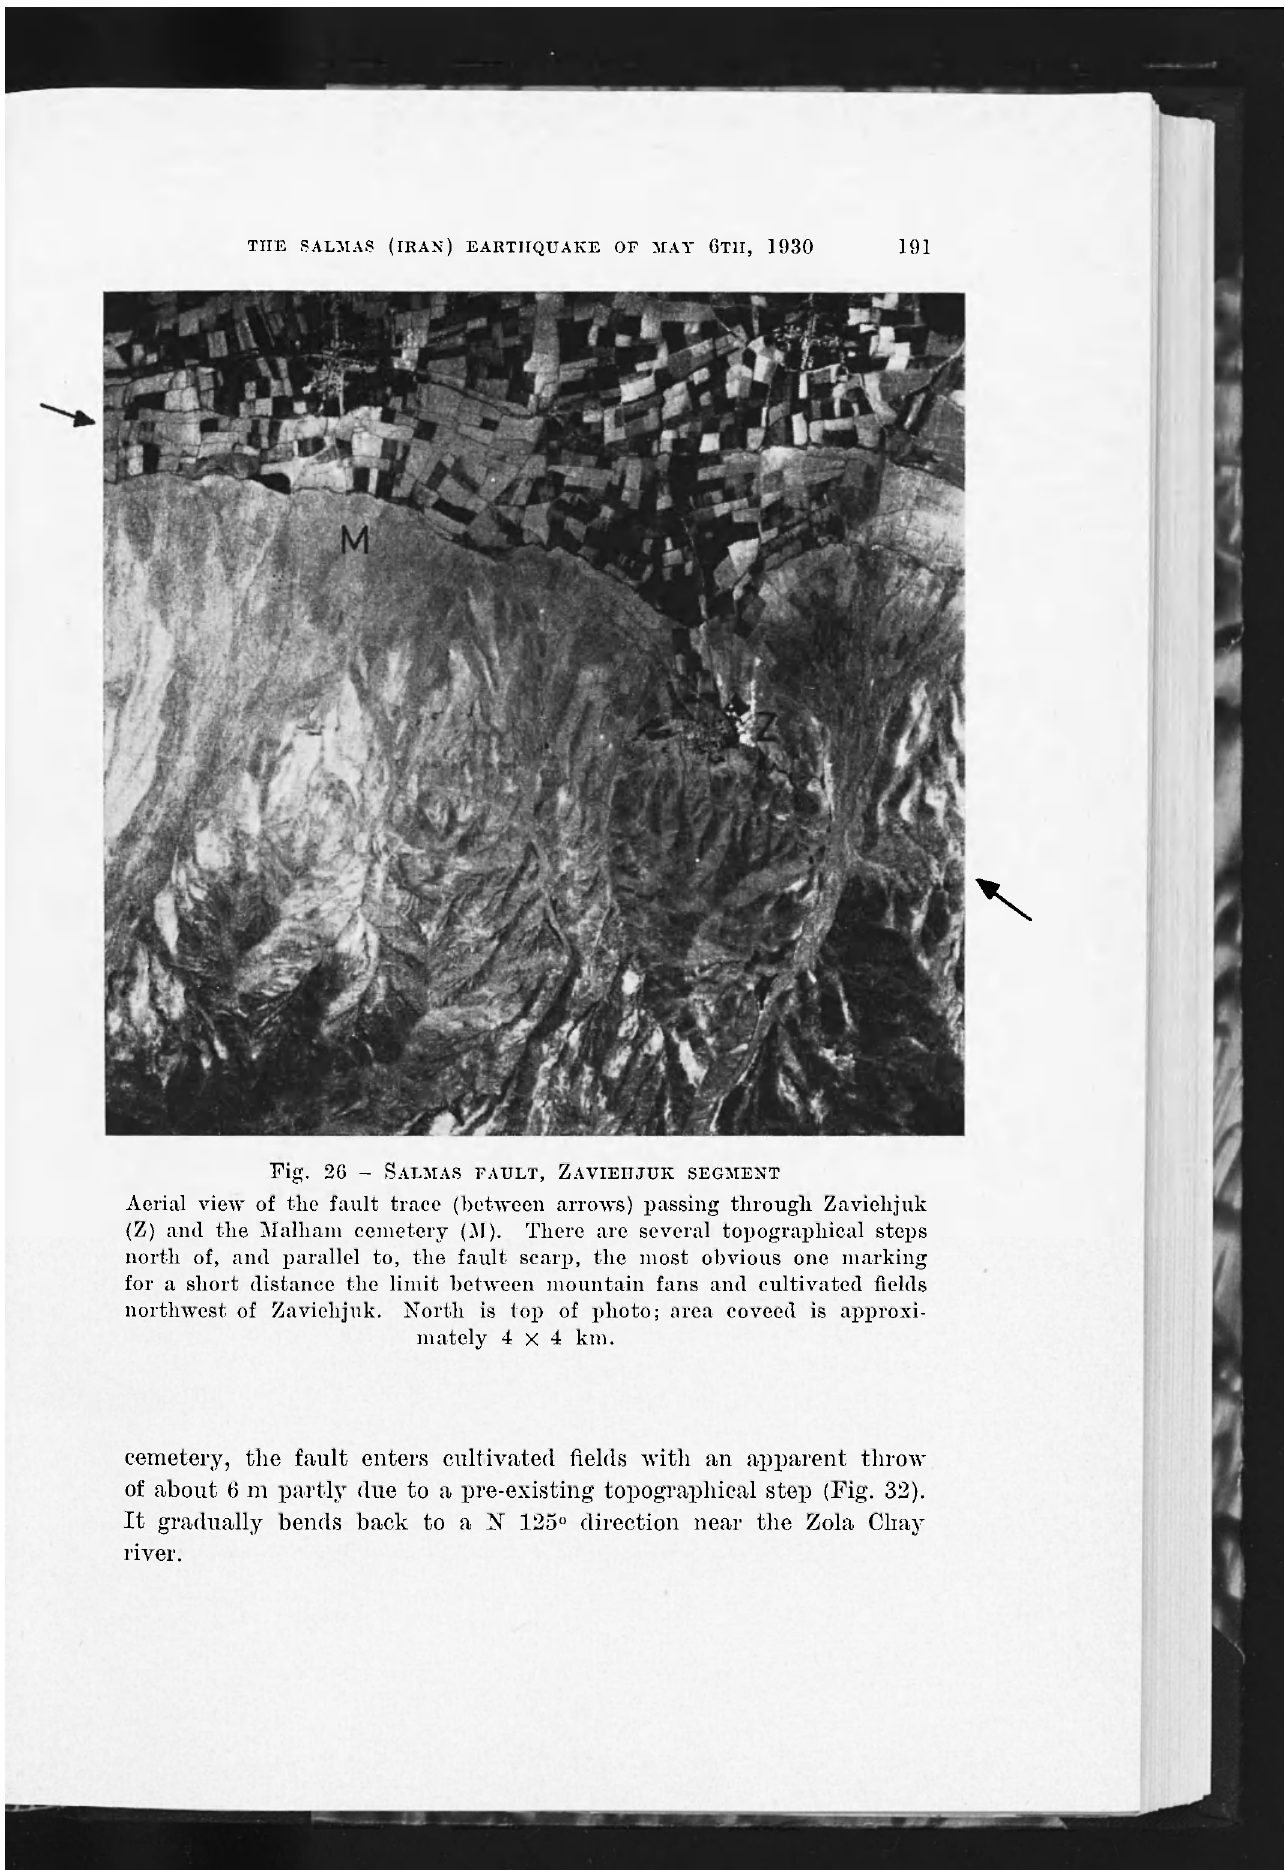
Fig. 26 - SALMAS FAULT, ZAVIEHJUK